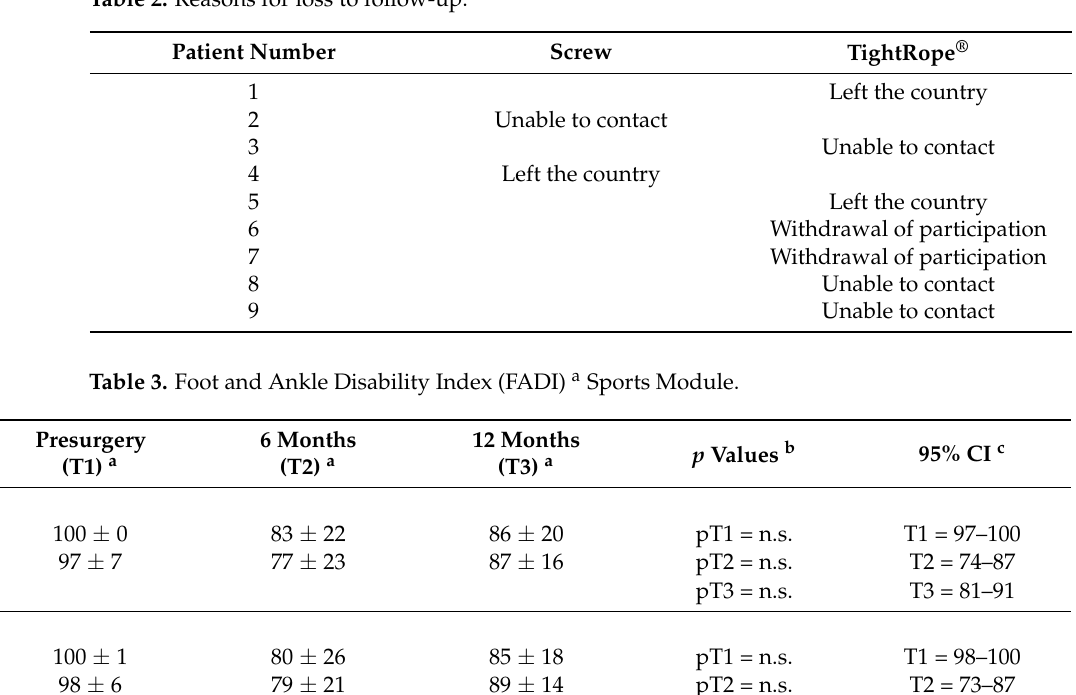
Table 2. Reasons for loss to follow-up.